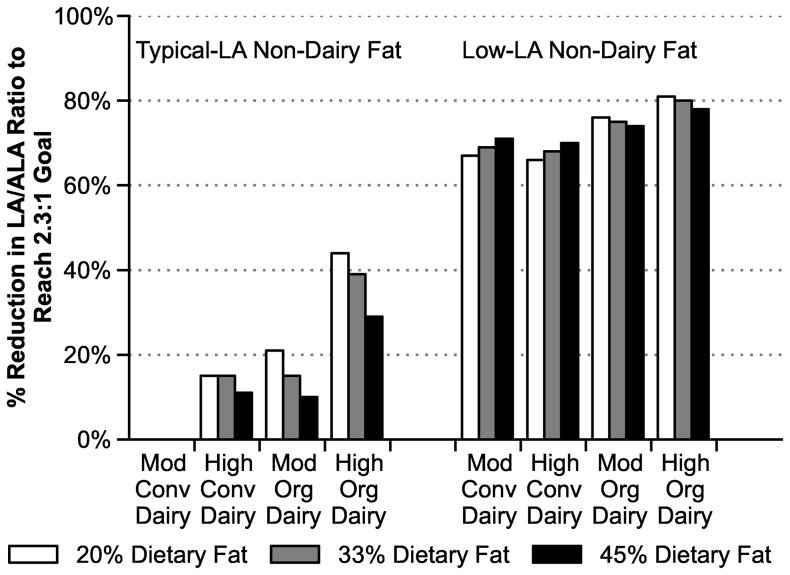
Percent progress toward a dietary LA/ALA ratio of 2.3 for hypothetical diets of an adult woman, relative to diets containing moderate amounts of conventional dairy products.The diets contain non-dairy fat sources with typical (left side) and low (right side) amounts of LA in the context of total dietary fat contributing 20%, 33%, or 45% of energy. Abbreviations: Mod  =  moderate, Conv  =  conventional, Org  =  organic.